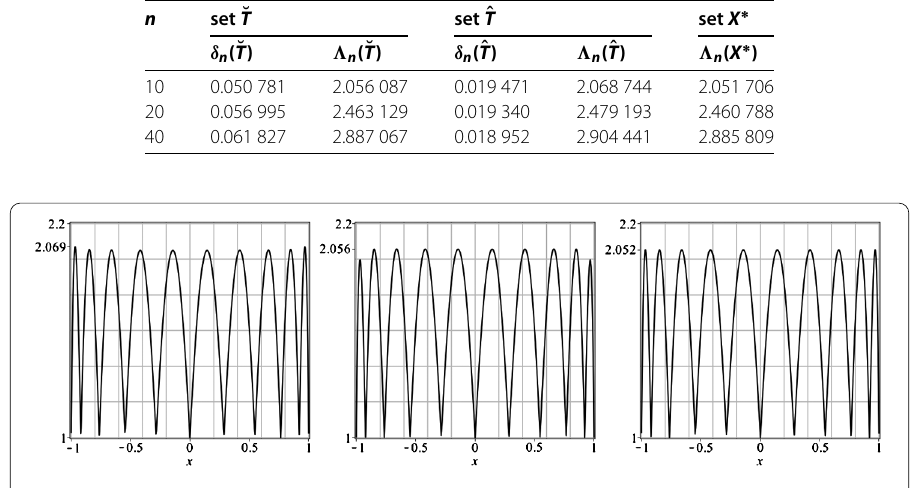
˘ T ), we can see that the set